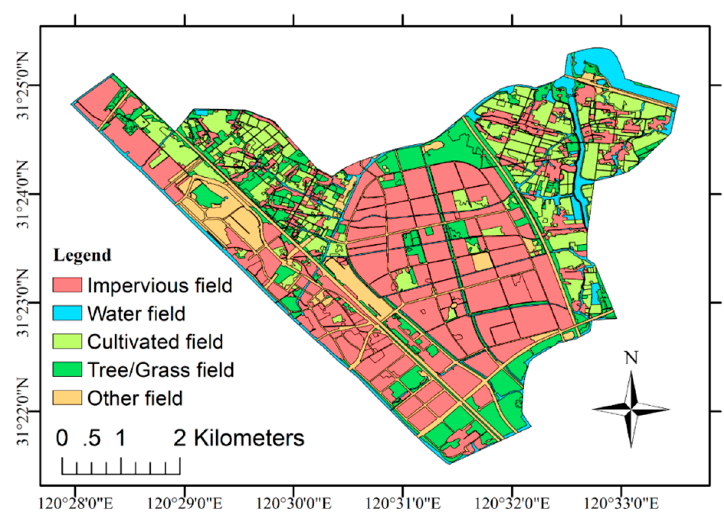
Figure 8. Results of the segmentation and distribution of automatically collected geo-object samples.